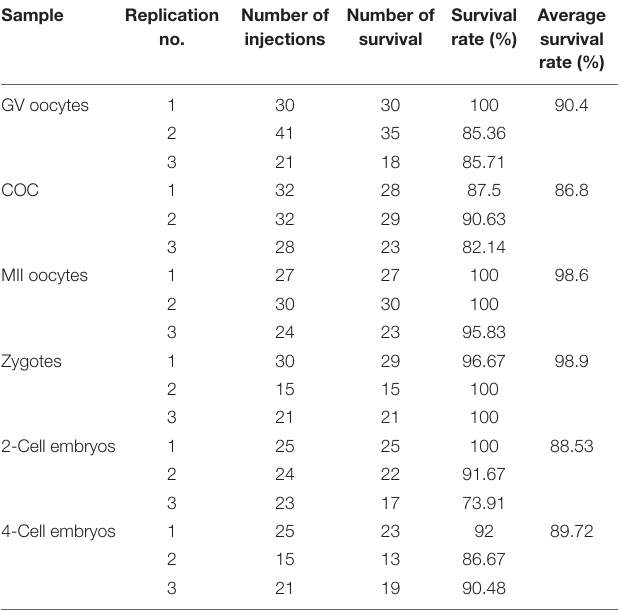
TABLE 1 | Statistics of microinjection results.